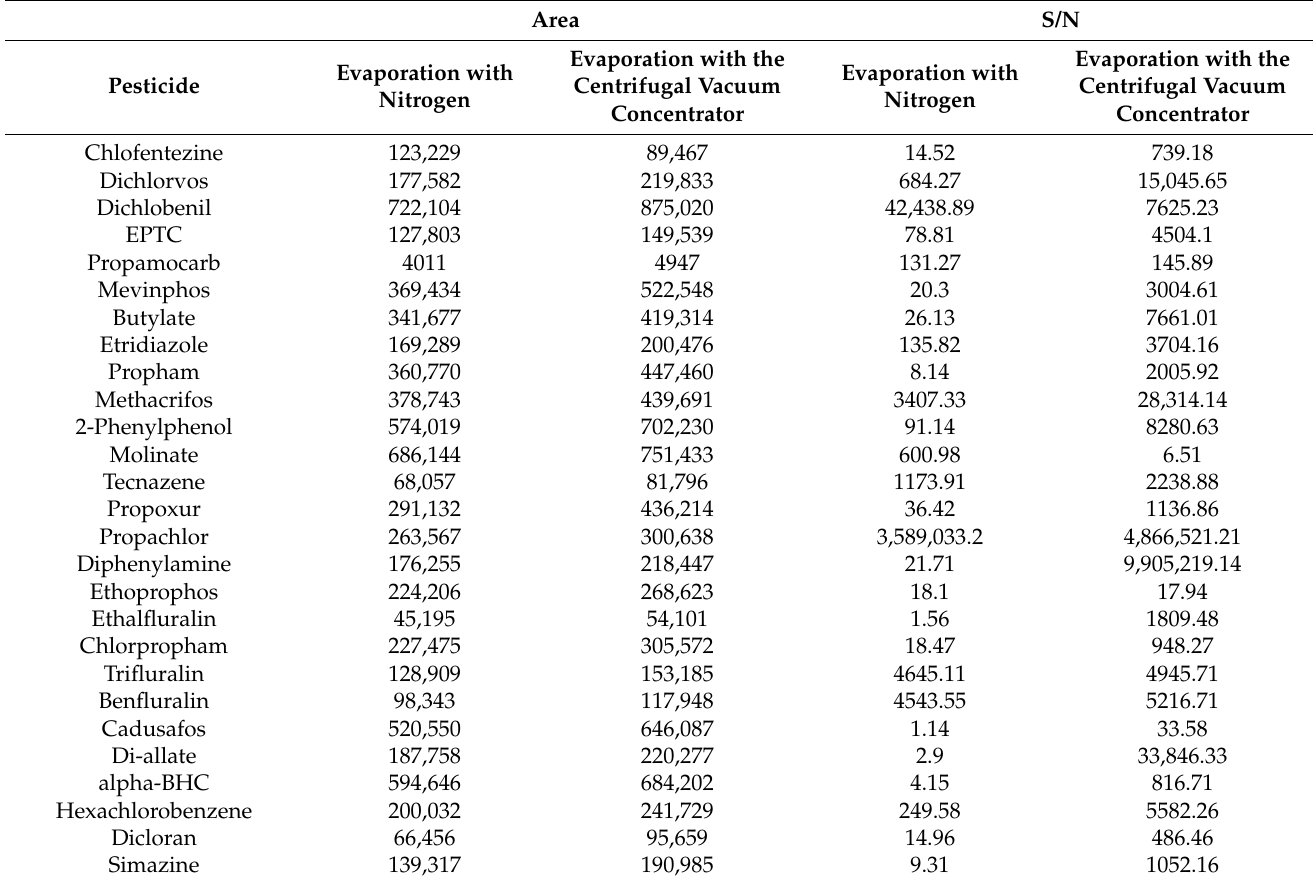
Table 3. Comparison of Area and S/N ratios values using the two different evaporation methods. Area